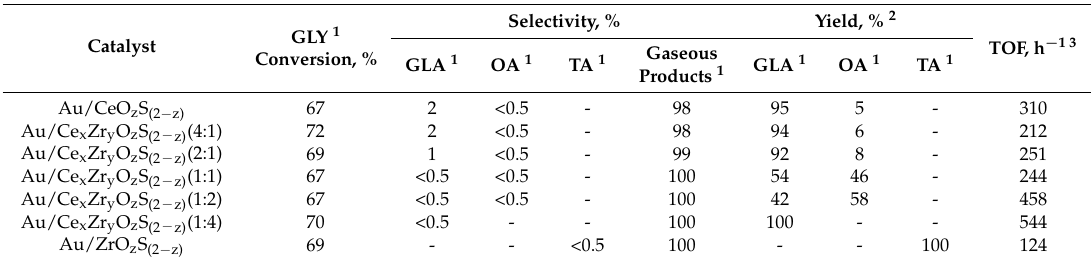
Table 7. The results of glycerol oxidation over gold catalysts at basic conditions at 333 K for 5 h. The oxides modified with sulfur were not active. Selectivity, % Yield, % 2 1 Catalyst GLY TOF, h − 13 Gaseous Conversion, % GLA 1 OA 1 TA 1 GLA 1 OA 1 TA 1 Products 1 Au/CeO z S (2 − z)